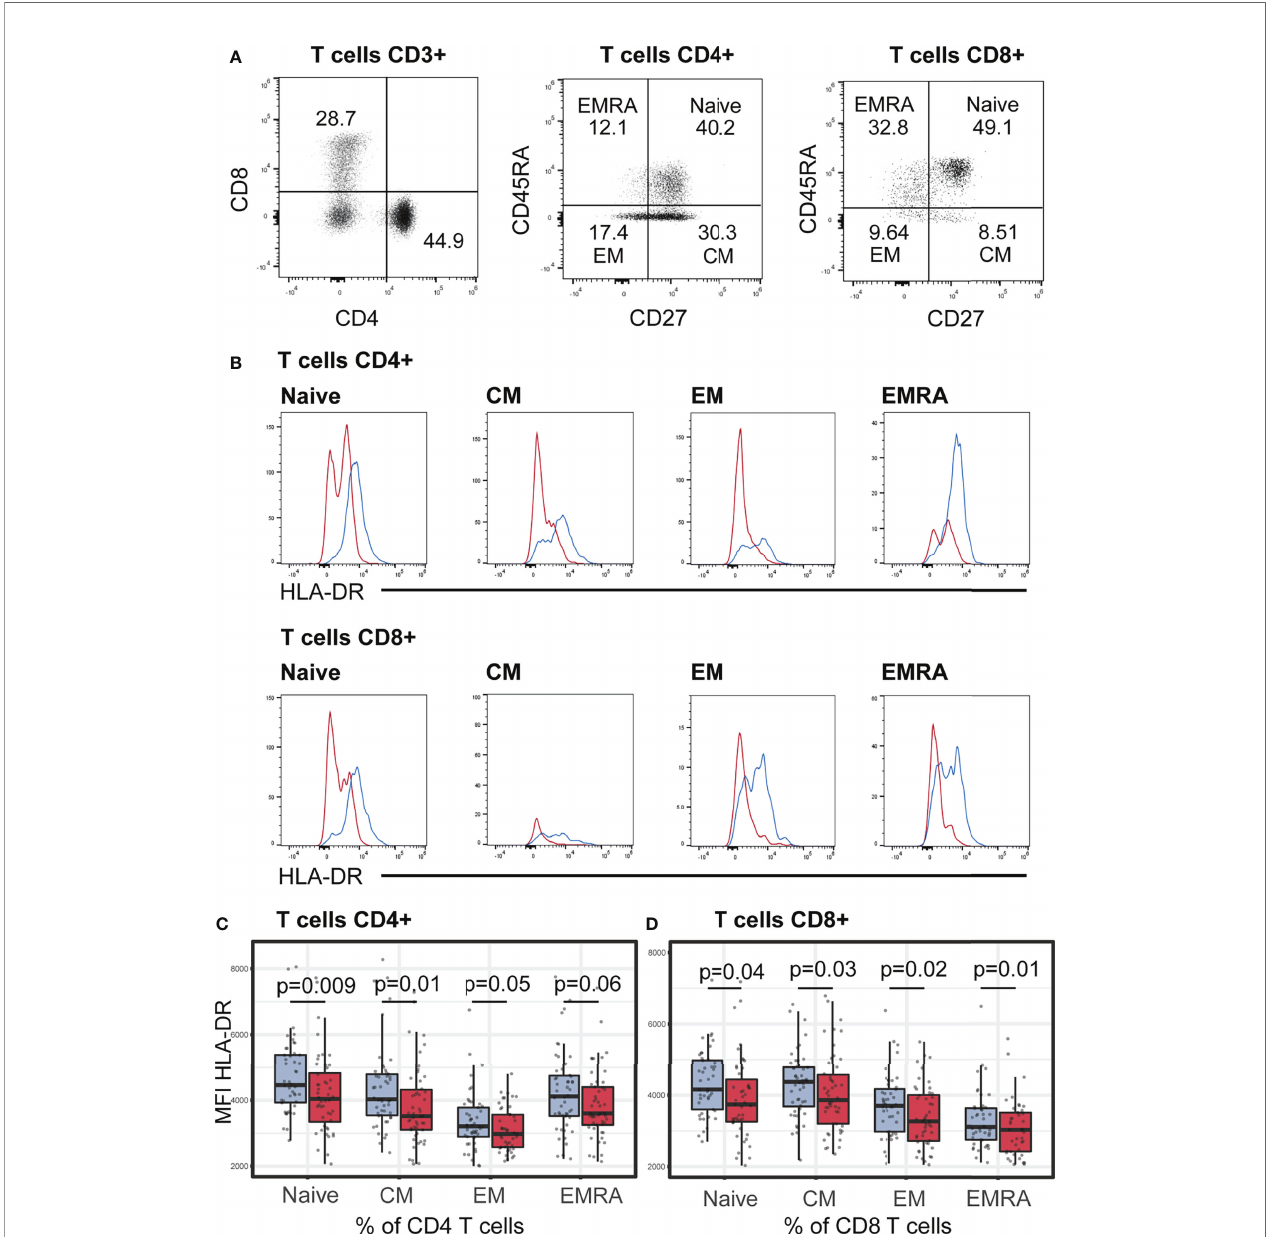
FIGURE 2 | HLA-DR expression (MFI) on helper T (CD4+) and cytotoxic T cells (CD8+). (A) Representative dot plots of the gating strategy of T cells subsets based on their surface expression of CD27 and CD45RA markers. In each T cell subsets, naïve (CD27 + CD45RA + ), central memory (CM, CD27 + CD45RA - ), effector memory (EM, CD27 - CD45RA - ), and CD45RA + effector memory (EMRA, CD27 - CD45RA + ) cells were de fi ned. Representative dot plots from a non-stunted child are shown. (B) Representative histograms of HLA-DR expression on surface of naïve, CM, EM, EMRA T cells in stunted (red) versus non-stunted (blue) children. (C, D) Boxplot displaying the MFI values within all the T cell subsets in stunted (red) versus non-stunted (blue) children. Signi fi cance (p<0.05) was determined by Benjamini- Hochberg correction after Mann-Whitney test. N total= 101, N non-stunted = 50, N